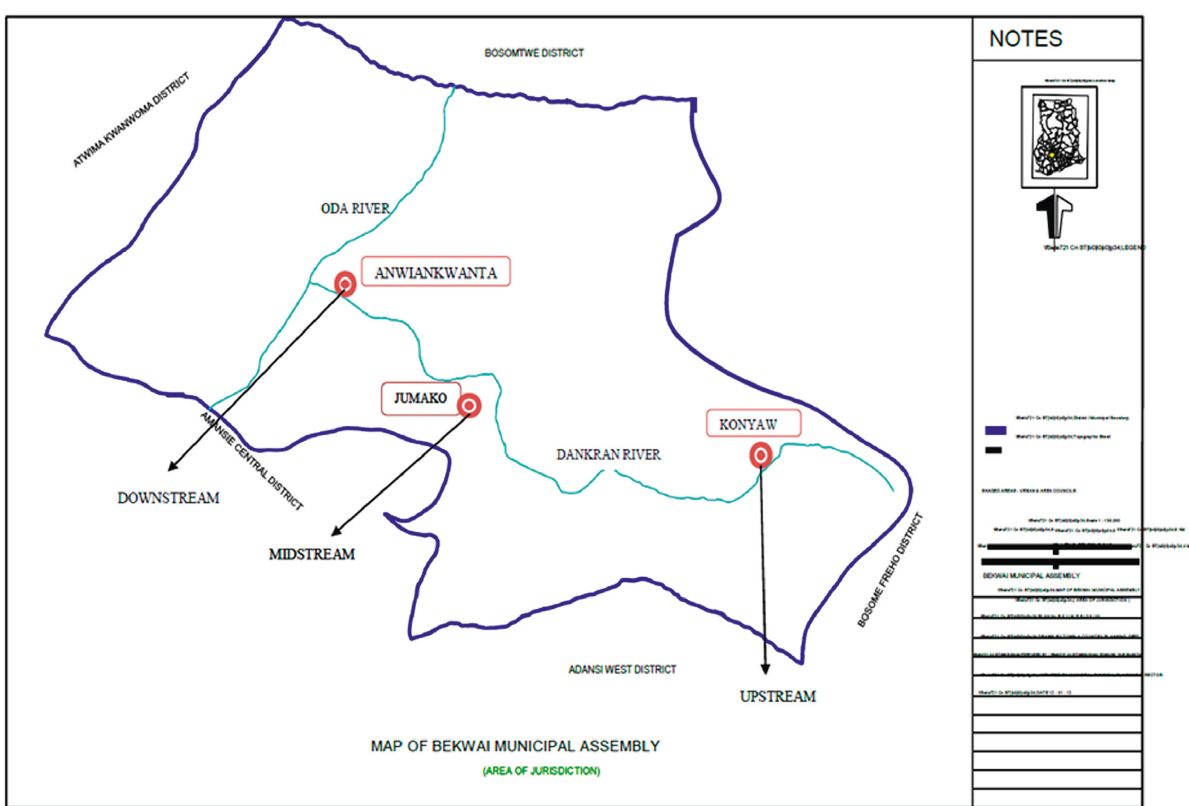
Figure 2: Map of the Dankran river showing the various points of sample collection. Table 1: Different standards prepared for a particular analyte. Element